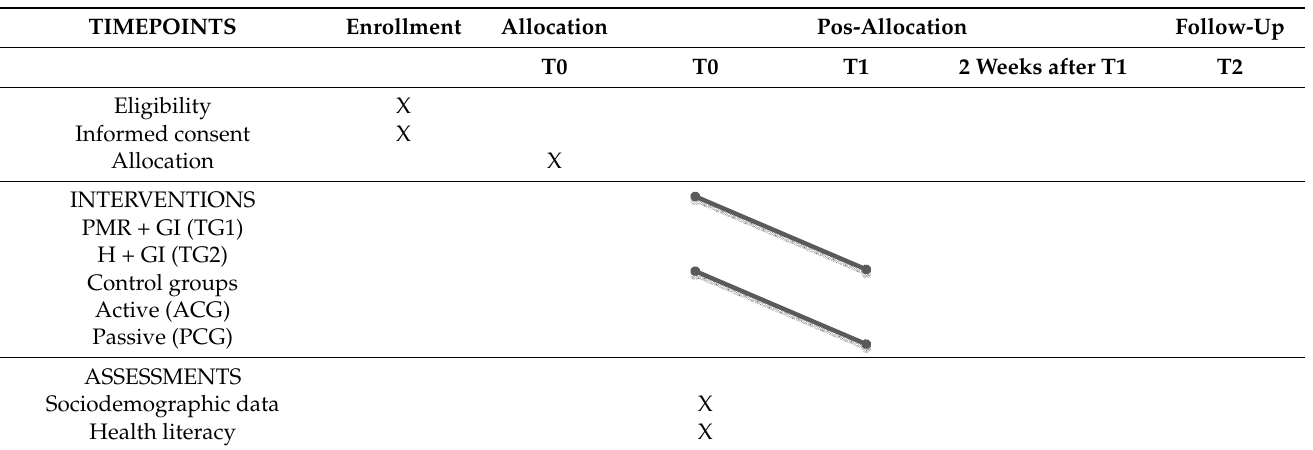
Table 1. Schedule of enrollment, interventions, and assessments of the PSY-DFU study, following the Standard Protocol Items Recommendations for Interventional Trials (SPIRIT) guidelines.